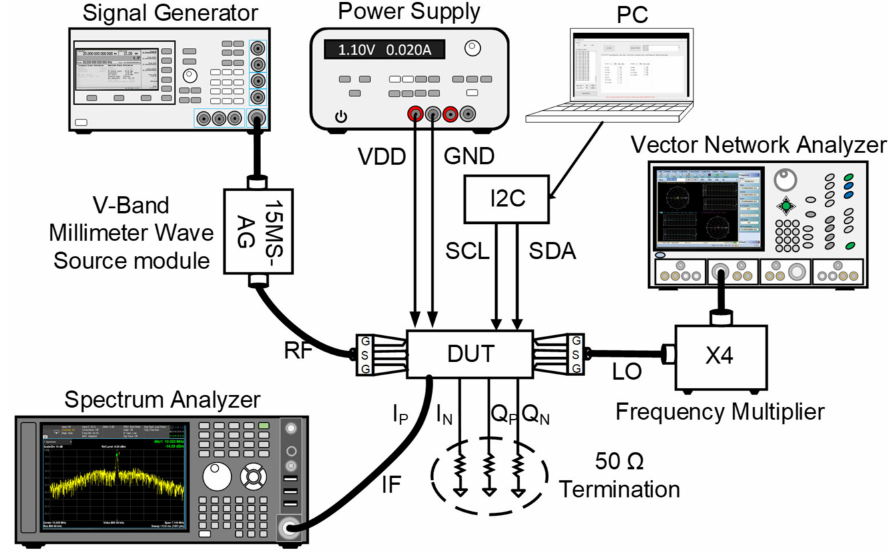
Figure 11. Measurement setup for 60 GHz CMOS I/Q receiver using spectrum